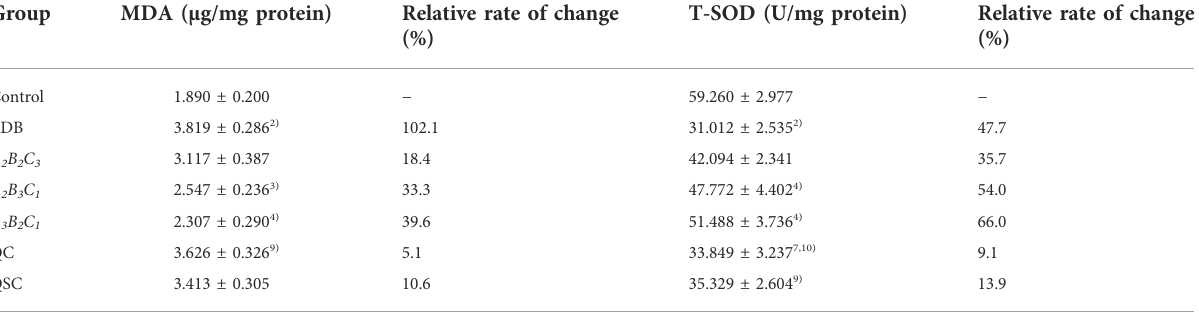
TABLE 7 Processing with ASR remarkably reversed hepatic lipid peroxidation and enhanced antioxidant levels in the liver of mice caused by RDB. Group MDA ( μ g/mg protein) Relative rate of change T-SOD (U/mg protein) Relative rate of change (%)